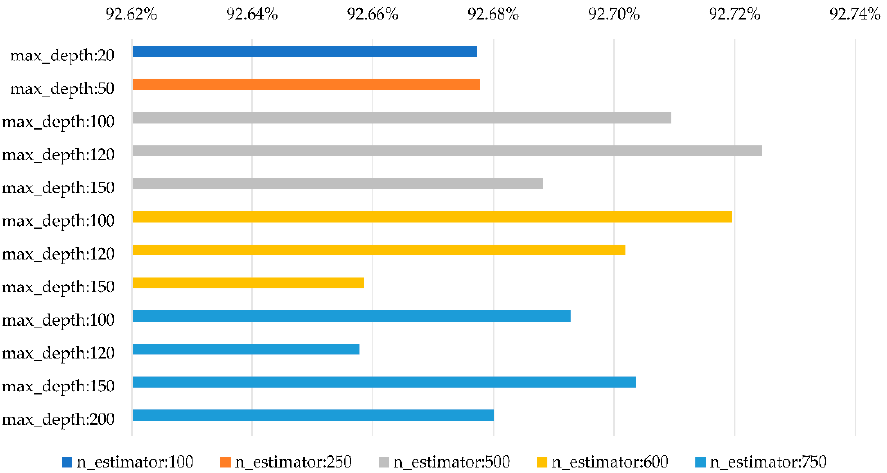
Figure 13. Test set classification accuracy of RandomForestClassifier with different sizes.